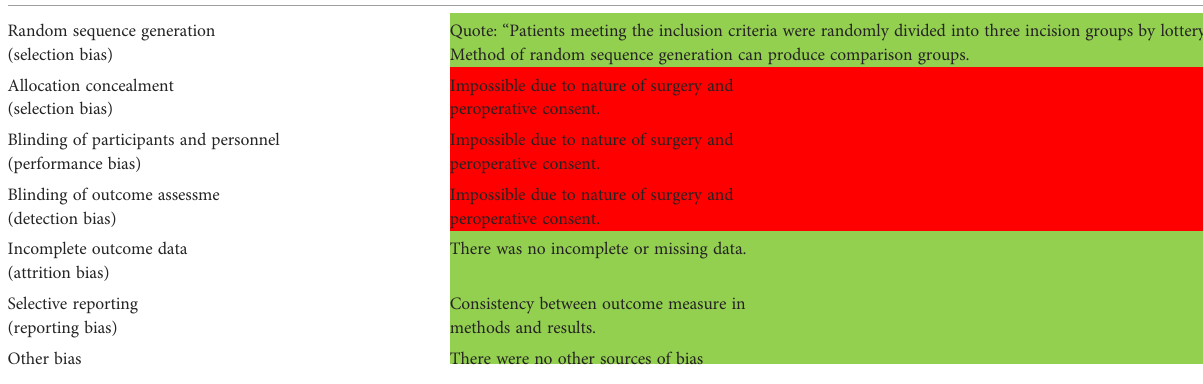
TABLE 3 Risk of bias of one RCT with Cochrane Collaboration